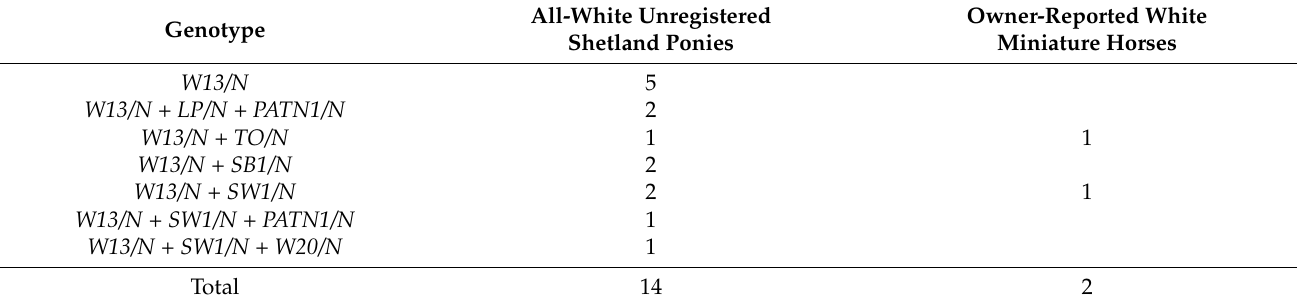
Table 3. Genotypes for white patterning loci in Shetland ponies and Miniature Horses with